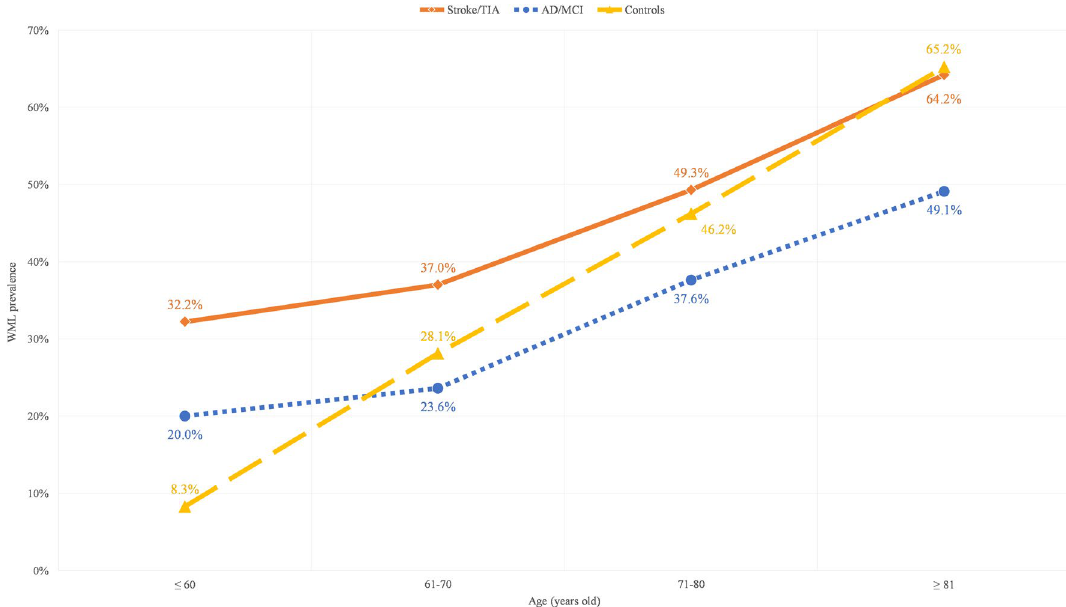
Figure 2. The prevalence of severe white matter lesion in different age groups in the AD/MCI group, stroke/ TIA group, and control group.